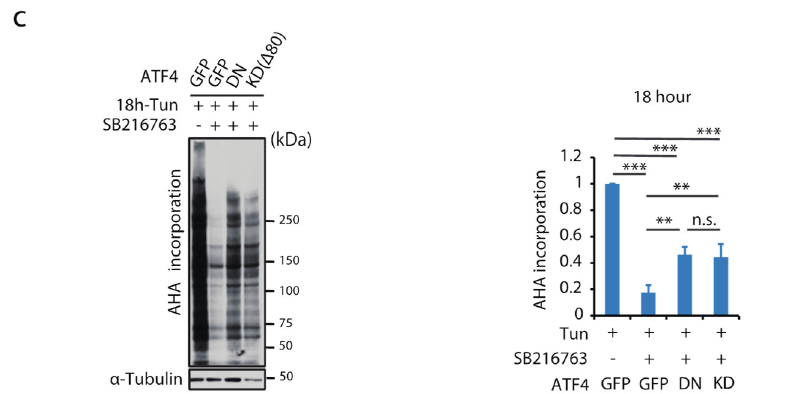
Figure 5. Inhibition of Gsk-3 activity alters change in global translation under ER stress. Metabolic labelling analysis using AHA in MIN6 cells treated with tunicamycin in the presence or absence of Gsk-3 inhibitor for the indicated time periods. AHA labelled nascent proteins in whole-cell lysates were assessed by Western blotting ( a ) using HRP-conjugated streptavidin ( n = 3). Relative AHA incorporation corrected by α -tubulin was expressed graphically. ** p < 0.01, *** p < 0.001 by two-way ANOVA followed by Bonferroni’s post hoc test. Effect of inhibition of ATF4 function by introducing DN-ATF4 or shRNA( ∆ 80) on AHA incorporation following ( b ) a 10 h and ( c ) a 18 h treatment with tunicamycin ( n = 3). Relative AHA incorporation corrected by α -tubulin is shown as mean ± SD in the graph. ** p < 0.01, *** p < 0.01 by one-way ANOVA followed by Bonferroni’s post hoc test. n.s., not